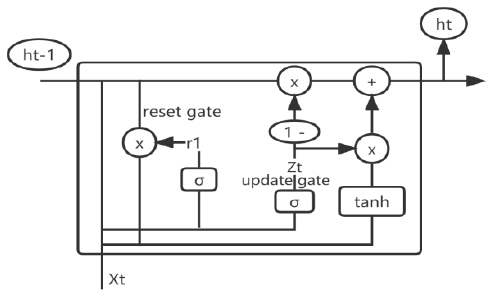
Figure 5. GRU network